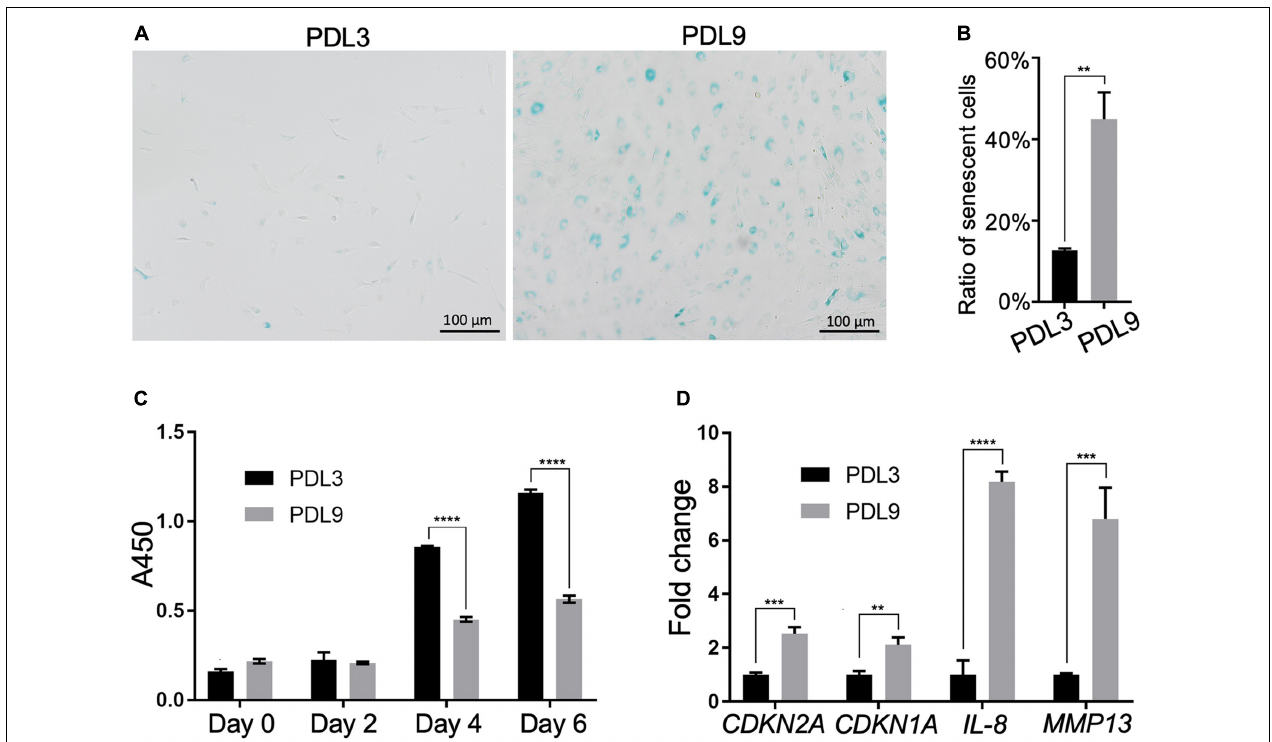
FIGURE 1 | Comparison of senescent level between PDL3 and PDL9 chondrocytes. (A) SA- β -gal staining. Bar = 200 µ m. ( B ) Ratios of senescent cells. (C) CCK-8 assay was used to assess cell proliferation potential. (D) Expression levels of senescence-relevant genes. The data was normalized to that in PDL3 group (set as 1). ** p < 0.01; *** p < 0.001; **** p <